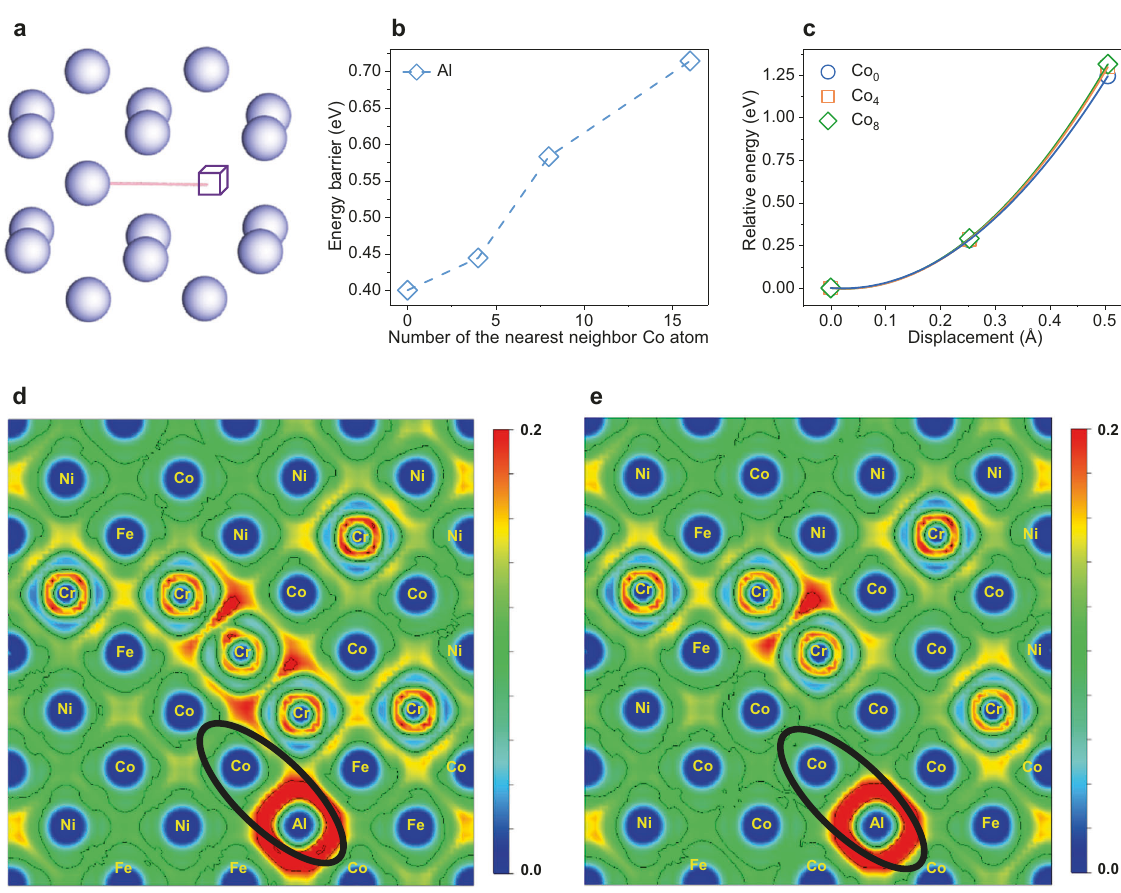
d , e ELFplotina[100]planecorrespondingtothecaseof c atdifferentnumbersof the nearest neighbor Co atoms. Note that ELF=0 and 1 represent the completely delocalized and perfect localization of electrons, respectively. Color scale of the ELF value difference ranges from 0 to